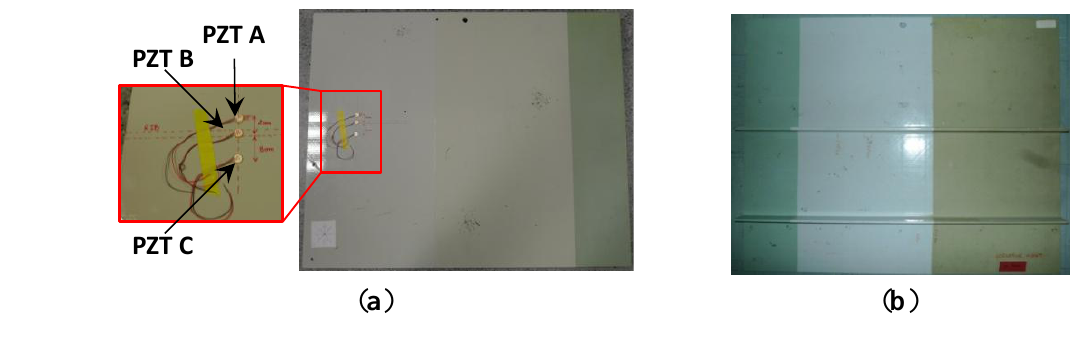
Figure 18. Wing front spar specimen ( a ) Front side view of the structure with PZT A at 2 cm from the rib, PZT B pasted onto the rib and PZT C at 3 cm from the rib ( b ) back side of the